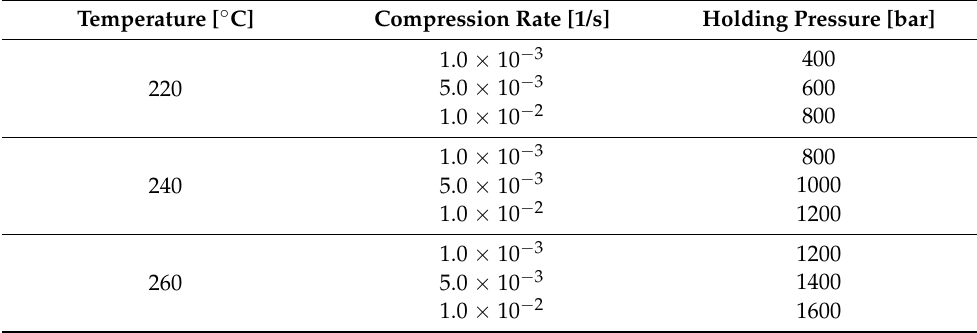
Table 2. Experiments to determine the pressure-dependent equilibrium time of the COC; all pressures were varied at each temperature and compression